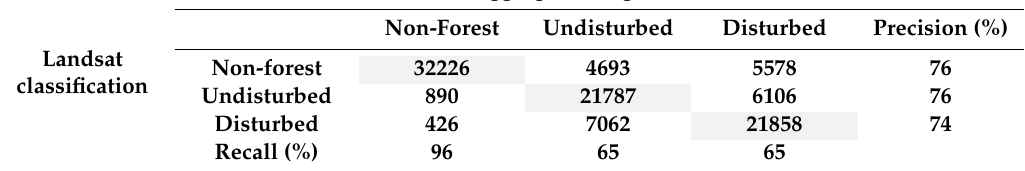
Shaded cells indicate correctly classified